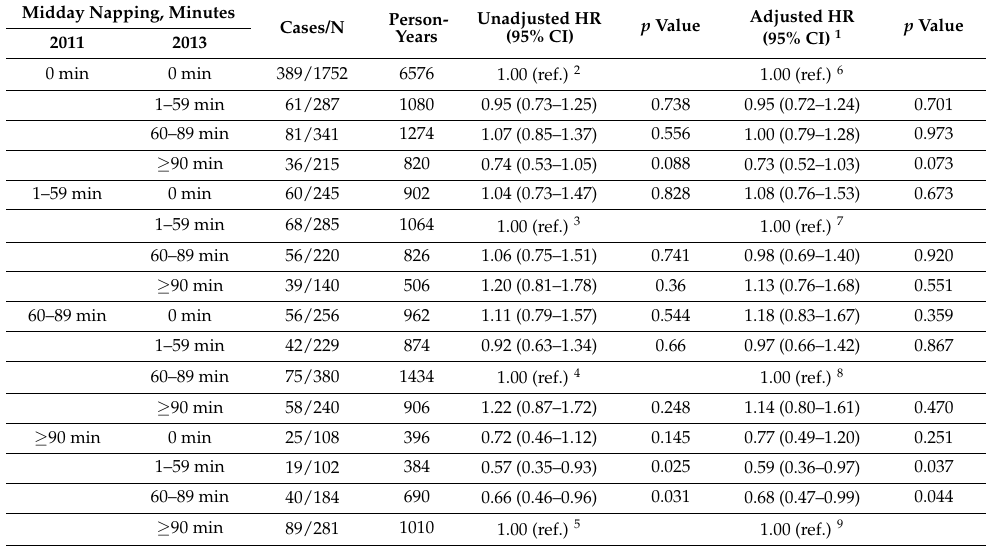
Table 3. Hypertension risk by subcategories of midday napping across baseline (2011) and follow-up